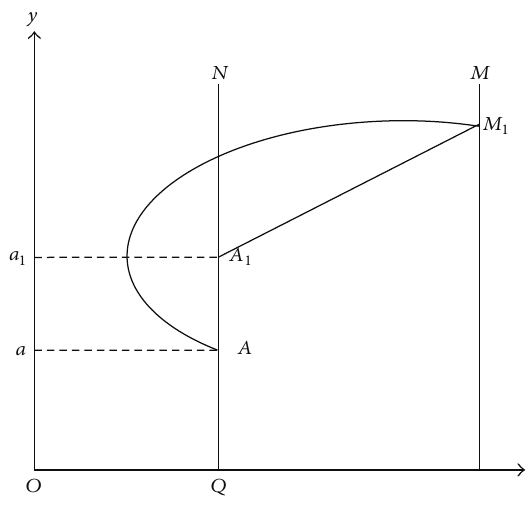
Figure 1: Successor function 𝑓(𝐴) = 𝑎 1 − 𝑎